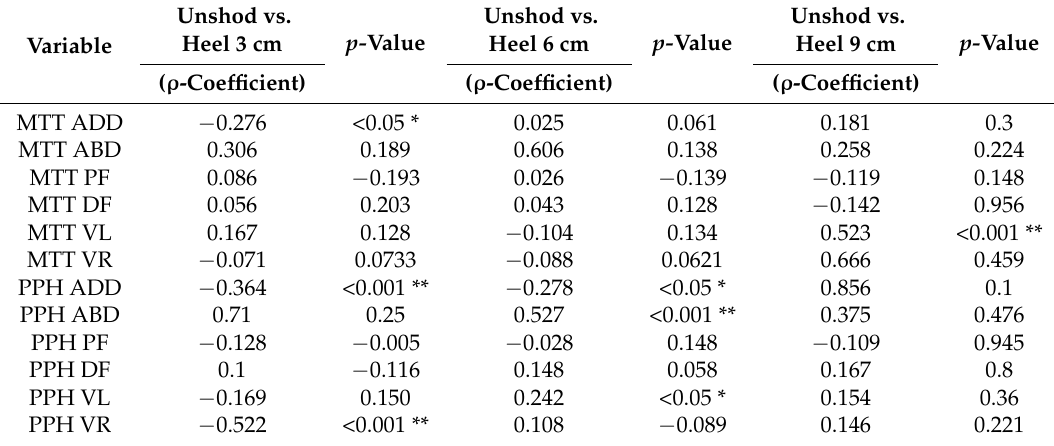
Table 7. DINADYNAMIC Spearman-Rho correlation coefficients between